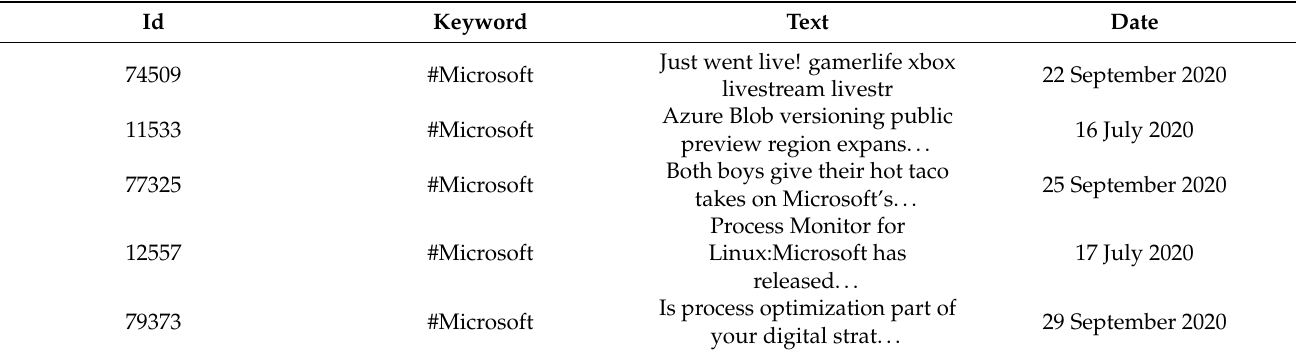
Table 1. Sample of Twitter data.